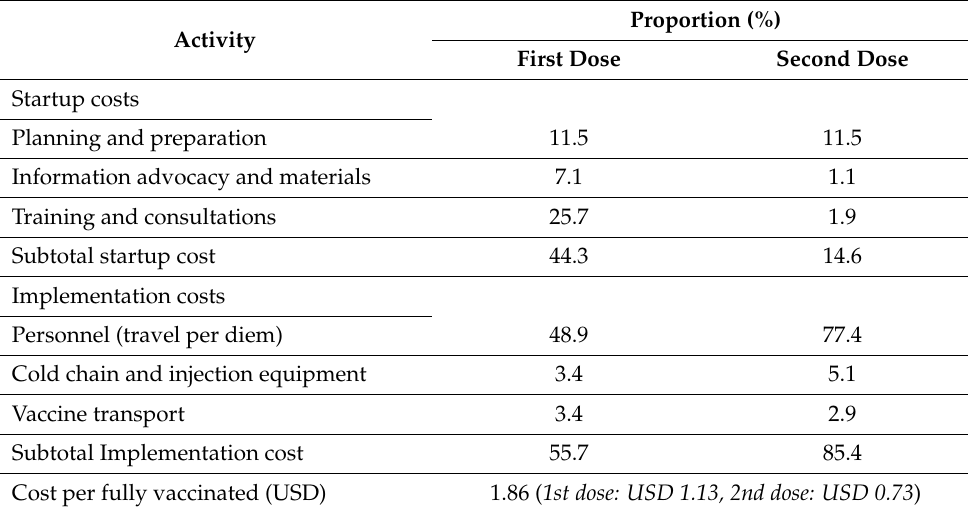
Table 2. Cost distribution by activity and cost per fully vaccinated, Bhutan,